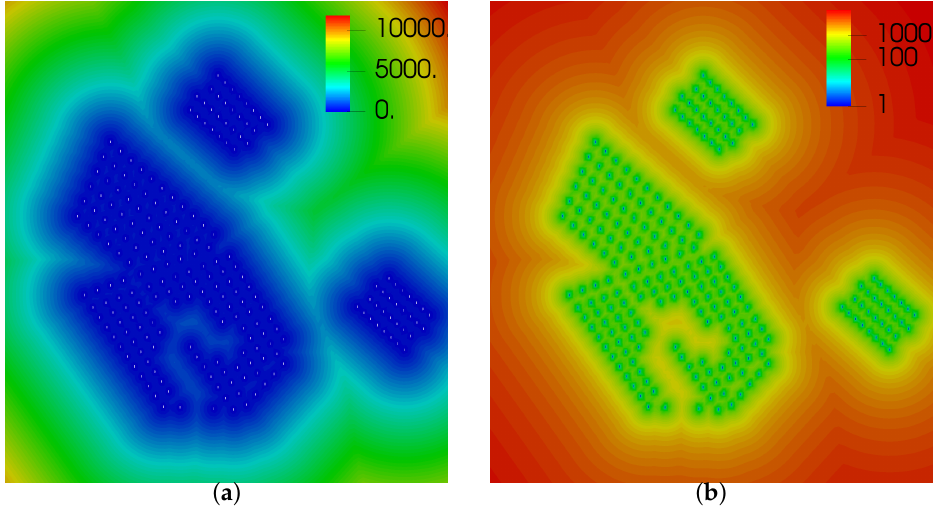
Figure 5. Wind farm test case featuring 219 turbines: ( a ) level set, ( b ) level set in logarithmic scale.